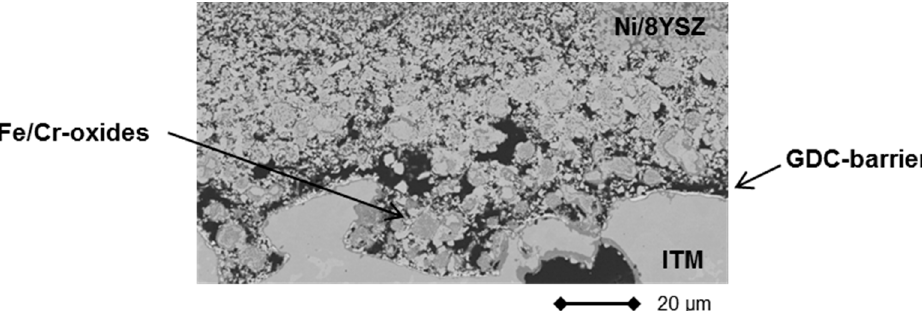
Figure 8. Cross-section of MSC 2 after operation in a stationary design exhibiting interdiffusion phenomena at contact interface between substrate/DBL/anode.